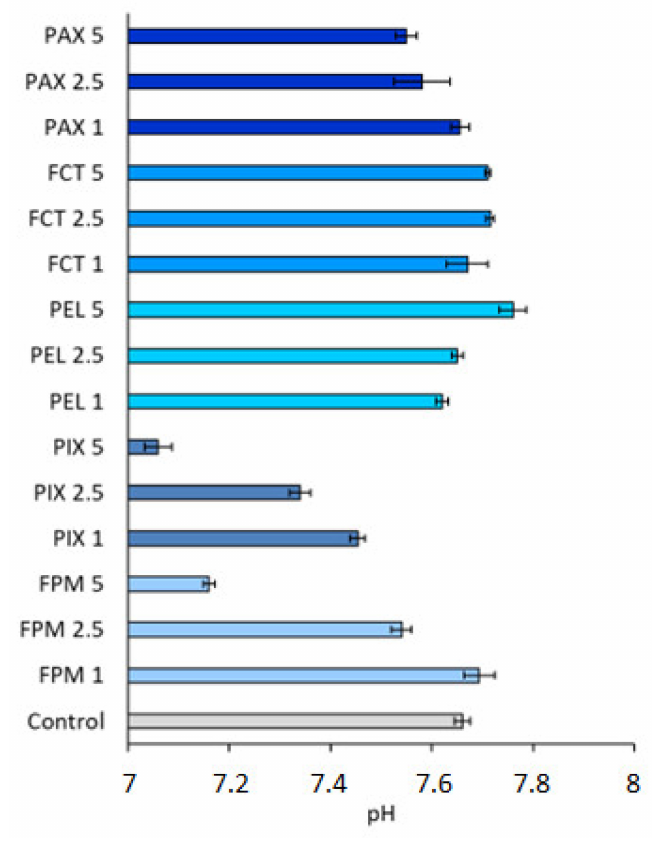
Figure 5. The pH of wastewater after dosing with